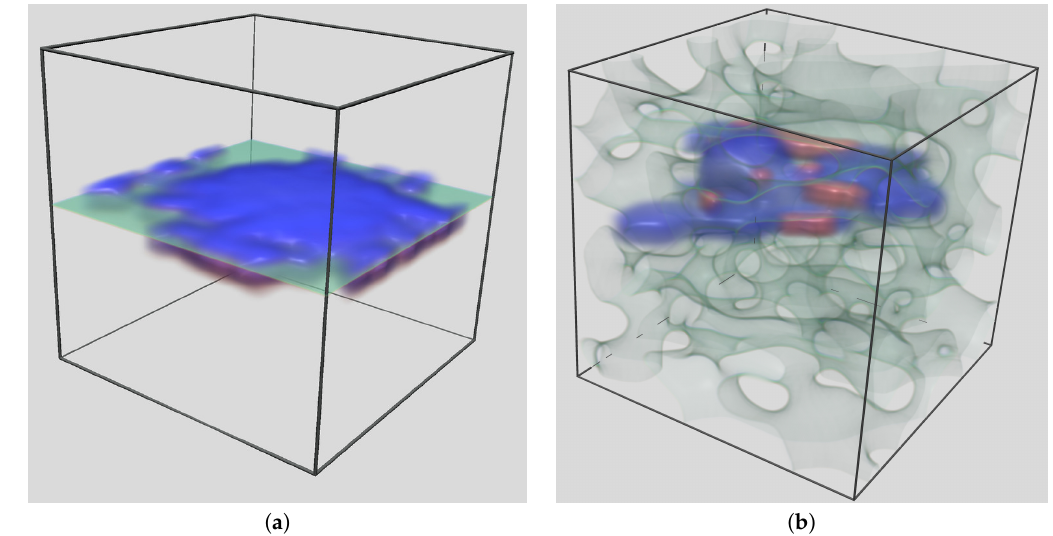
Figure 12. These images show examples of simulations (( a ) Flat Interface, ( b ) Complex Interface) where the charge transport shows an unexpected behavior. The interaction between the two charges (donor in blue/acceptor in red) is so strong that they stick together for the entire simulation time. They never reach the electrode. The strength of this effect only became visible to the physicist through these visualizations. This observation led to a reconsideration of several simulation parameters and the introduction of the ‘distance between charge pairs’ as additional efficiency